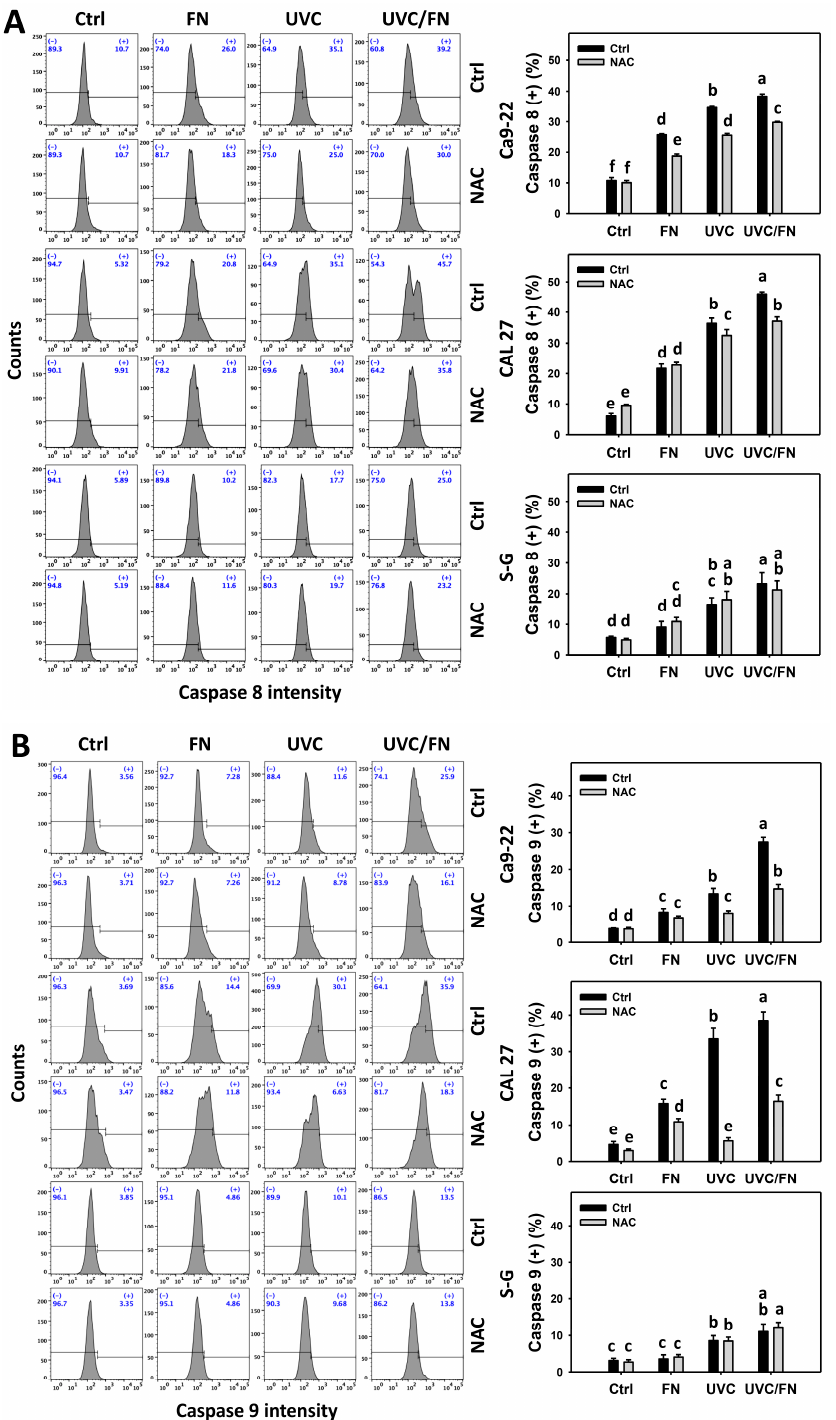
Figure 5. Extrinsic and intrinsic signaling determination. ( A ) Caspase 8. ( B ) Caspase 9. There are four kinds of treatments for oral cancer and non-malignant oral (S–G) cells: control, FN (300 µ g/mL), UVC (10 J/m 2 for Ca9-22; 15 J/m 2 for CAL 27 and S–G), and UVC/FN (10 J/m 2 /300 µ g/mL for Ca9-22; 15 J/m 2 /300 µ g/mL for CAL 27 and S–G). NAC indicates that cells were pretreated with 10 mM NAC. Their intensity changes were evaluated by flow cytometry after 24 h treatment. Caspase 8 (+) and caspase 9 (+) populations are indicated by (+). Data are given as means ± SD ( n = 3). Lower-case letters indicate significant differences when non-overlapping ( p <